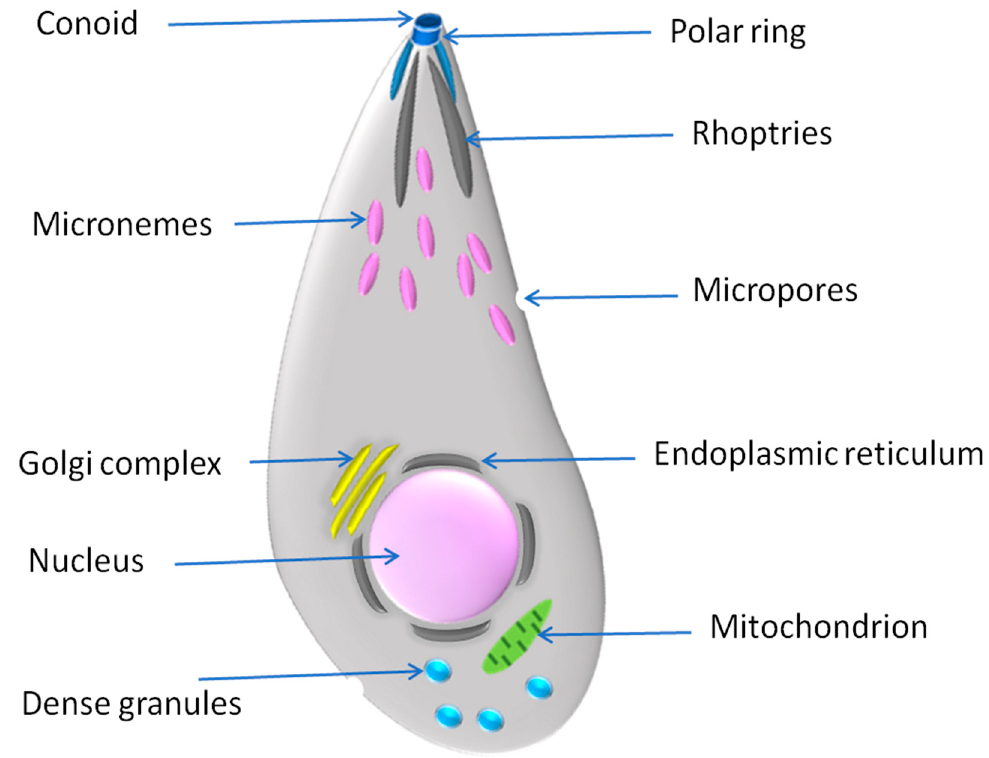
Figure 1. Ultrastructure showing an illustration for the common vital cell organelles in the tachyzoite of T. gondii and N. caninum.